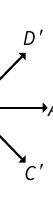
Figure 6. The four directions of the center